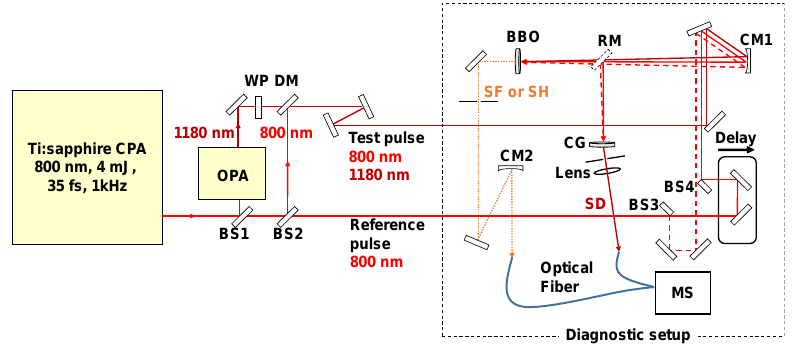
Figure 1. Experimental setup. WP: half-wave plate; DM: dichroic mirror; CM1,2: concave mirror; SF: sum-frequency signal; SH: second harmonic signal; SD: self-diffraction signal; BBO: BBO crystal; RM: removable mirror; MS: multi-channel spectrometer; BS1–4: beam splitter; CG: cover glass.